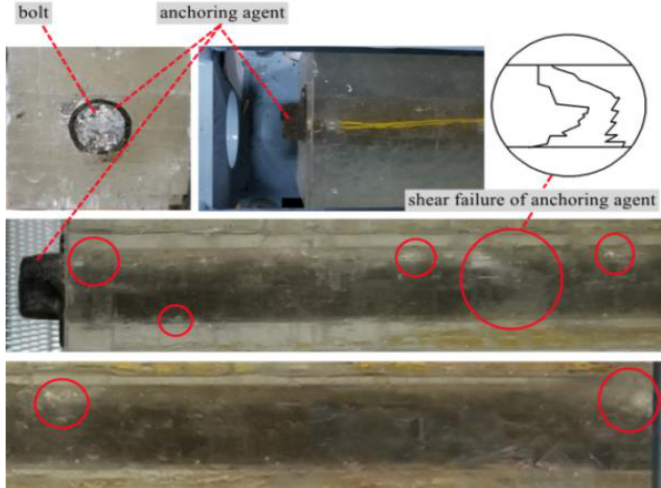
Figure 10. Debonding failure of anchoring agent.